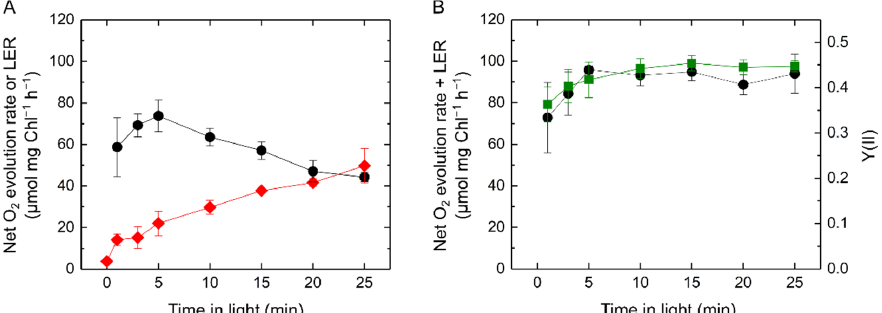
Figure 2. Light-enhanced respiration (LER) in Synechocystis sp. PCC 6803. The cyanobacterial cells adapted to darkness for 24 h (10 µg Chl mL − 1 ) were illuminated with a red actinic light (190 µmol photons m − 2 s − 1 ) for 20 min as indicated by black arrows. We defined the O 2 uptake rate just after the light was turned off as LER (red arrow). The representative data ( n = 9, biological replicates) are shown.